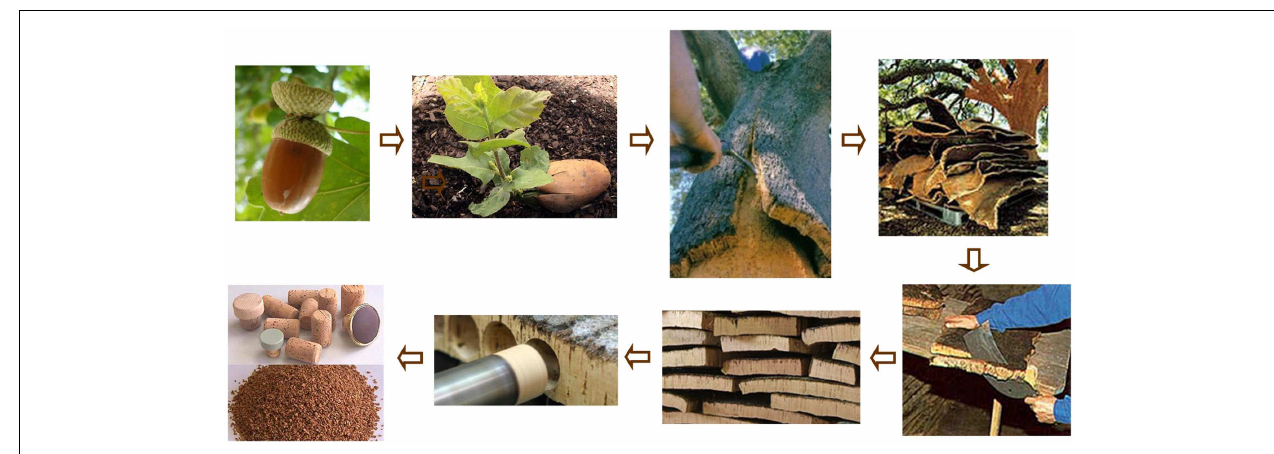
FIGURE 4 | From the cork oak ( Quercus suber L. ) to natural cork stoppers and cork granulates